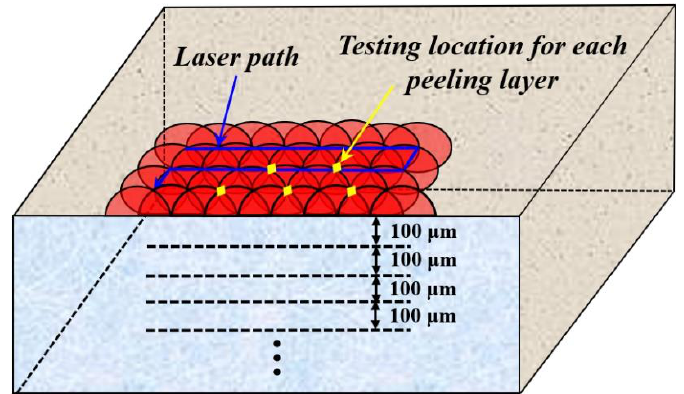
Figure 3. Test location for residual stress in the depth direction.